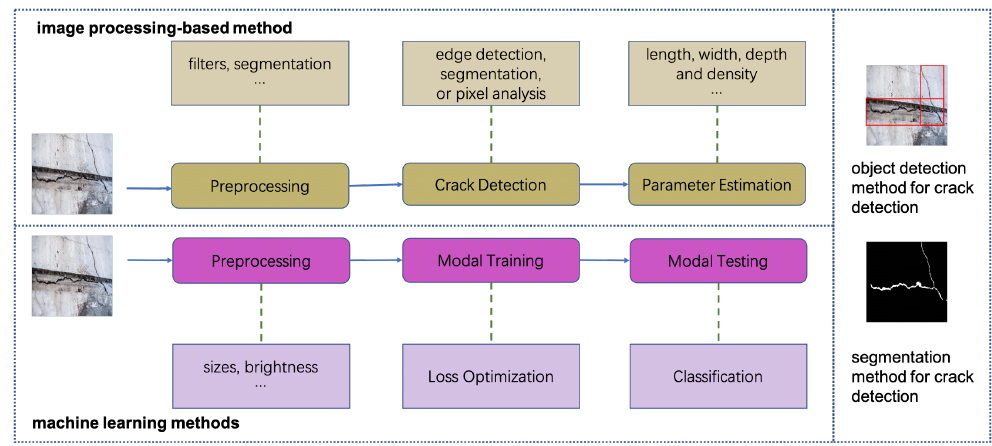
Figure 2. On the left are two methods of crack detection, including: (1) image processing-based method for crack detection, which utilizes handcrafted features; (2) machine learning method for crack detection, which utilizes learned features by the model. The right side shows that the methods based on machine learning include two categories, object detection method for crack detection and segmentation method for crack